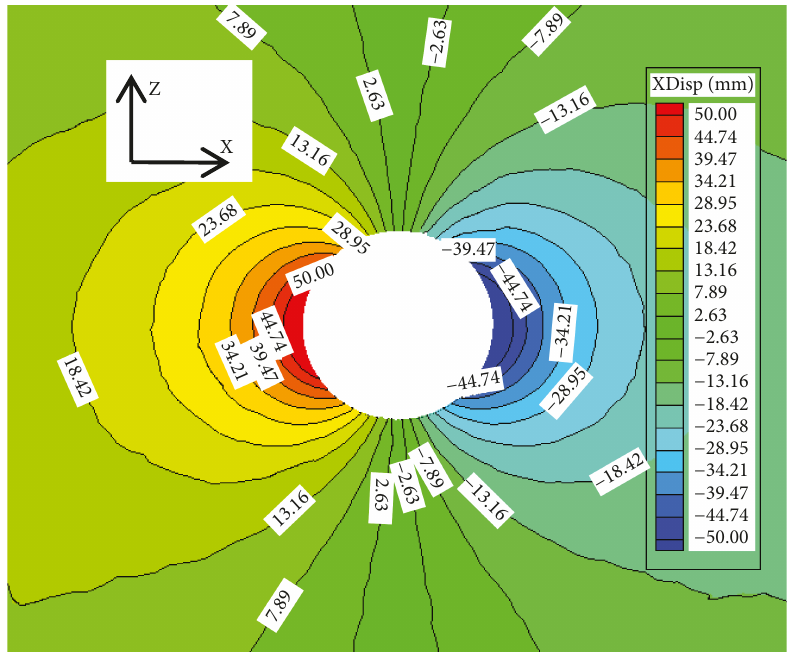
Figure 22: Displacement of section C-C along X.